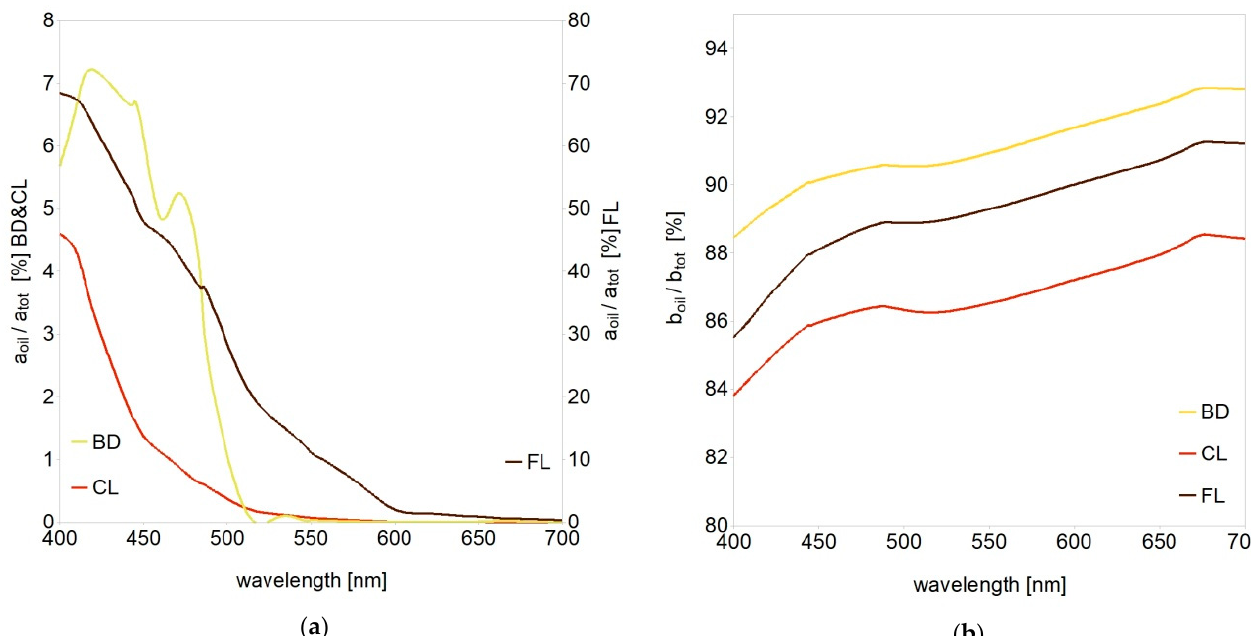
Figure 5. Percentage impact of ( a ) absorption and ( b ) scattering coefficients of dispersed oils to the total absorption and scattering of oligotrophic ocean water ( Chl-a = 0.1 mg/m 3 ) obtained as a result of Mie modeling.